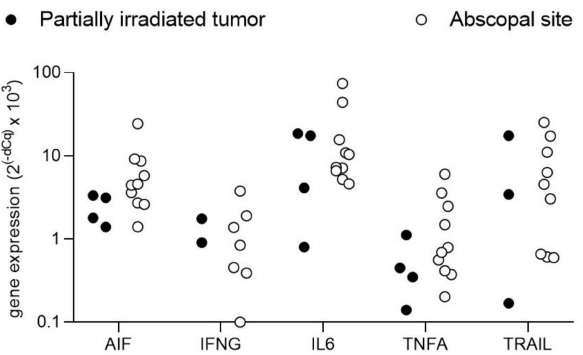
Figure 6. Gene expression analysis: Relative gene expression levels of apoptosis-inducing factor (AIF), interferon gamma (IFNG), interleukin 6 (IL-6), tumor necrosis factor alpha (TNFA) and TNF-related apoptosis-inducing ligand (TRAIL) in partially irradiated tumors (black circles) and abscopal sites (non-irradiated tumors and lymph nodes, empty circles) of four patients treated with SBRT-PATHY. Each circle represents the expression level of the indicated genes analyzed in duplicates in one tissue sample and normalized to the expression of the housekeeping gene